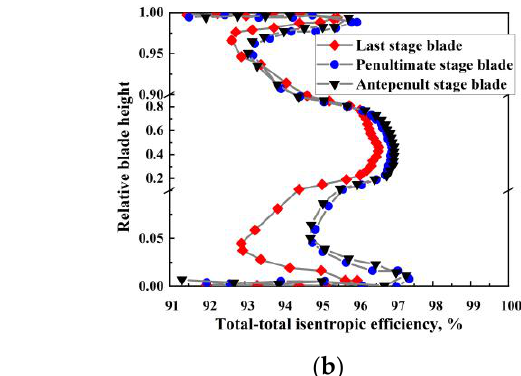
Figure 10. Distribution of the total-total isentropic efficiency along the blade height (2.7 MPa back pressure): ( a ) 100% load ratio; ( b ) 50% load ratio.